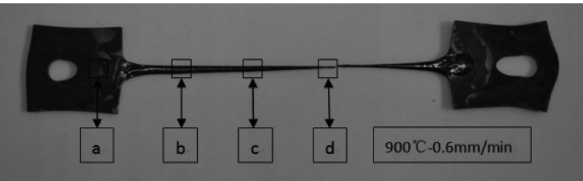
Figure 9: Transmission electron micrographs of superplastic deformed specimen (a) 850 ℃